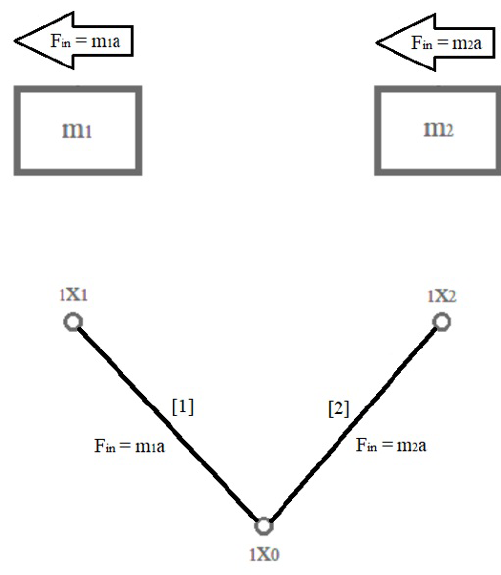
Figure 6. Graph edges representing inertia.